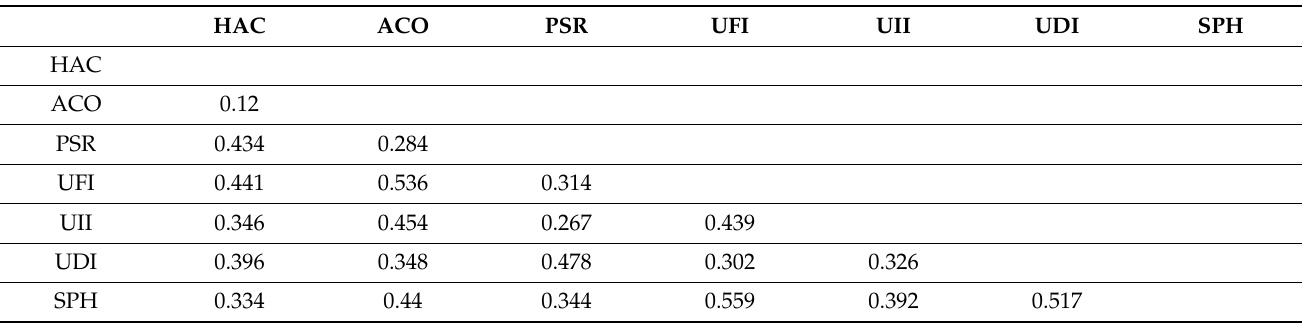
Table 4. Heterotrait–monotrait ratio (HTMT) test results.